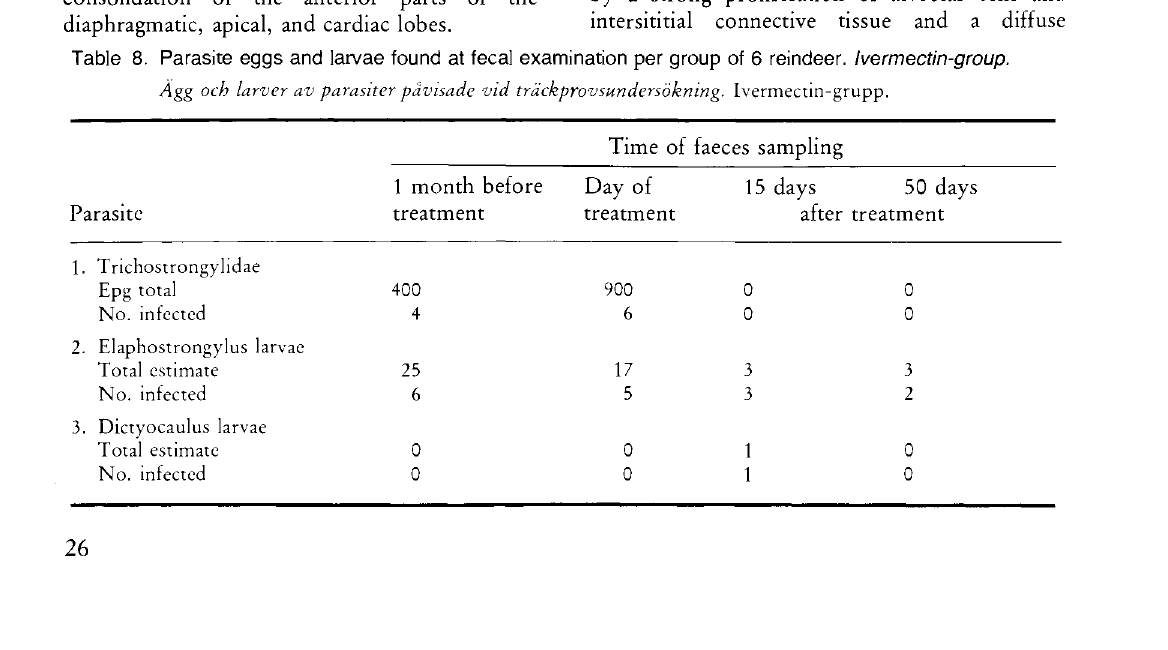
Table 8. Parasite eggs and larvae found at fecal examination per group of 6 reindeer. Ivermectin-group. Agg och larver av parasiter påvisade vid tràckprovsundersôkning.